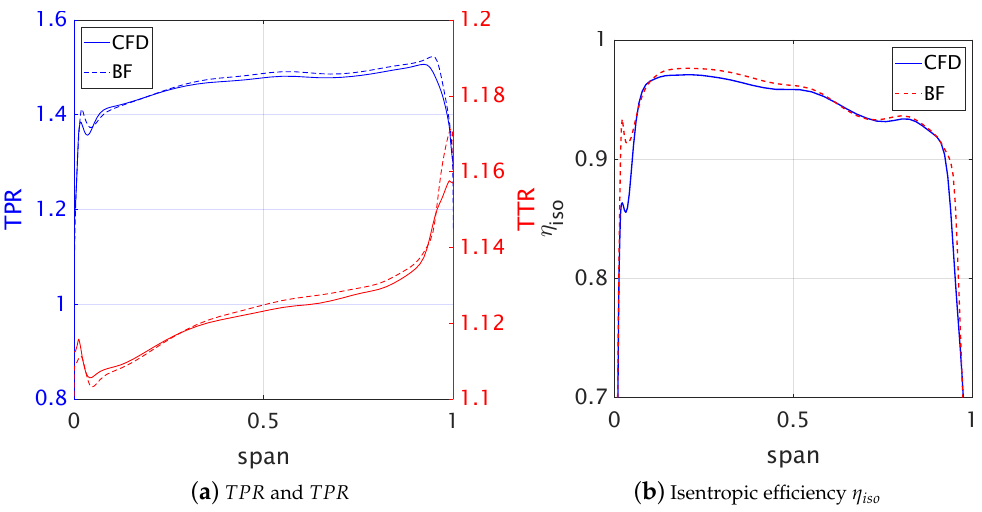
Figure 10. Spanwise distributions downstream of rotor blade for reference CFD solution and baseline body force model at peak